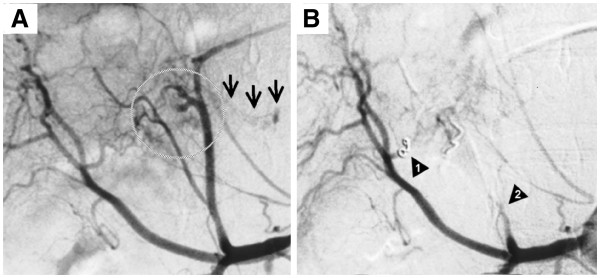
Visceral arteriography demonstrated a hypervascular tumor (A, circle) and extravasation (A, arrows), which disappeared after the embolization of one branch of the right hepatic artery (B, arrowhead 1) and the proximal portion of the left hepatic artery (B, arrowhead 2).